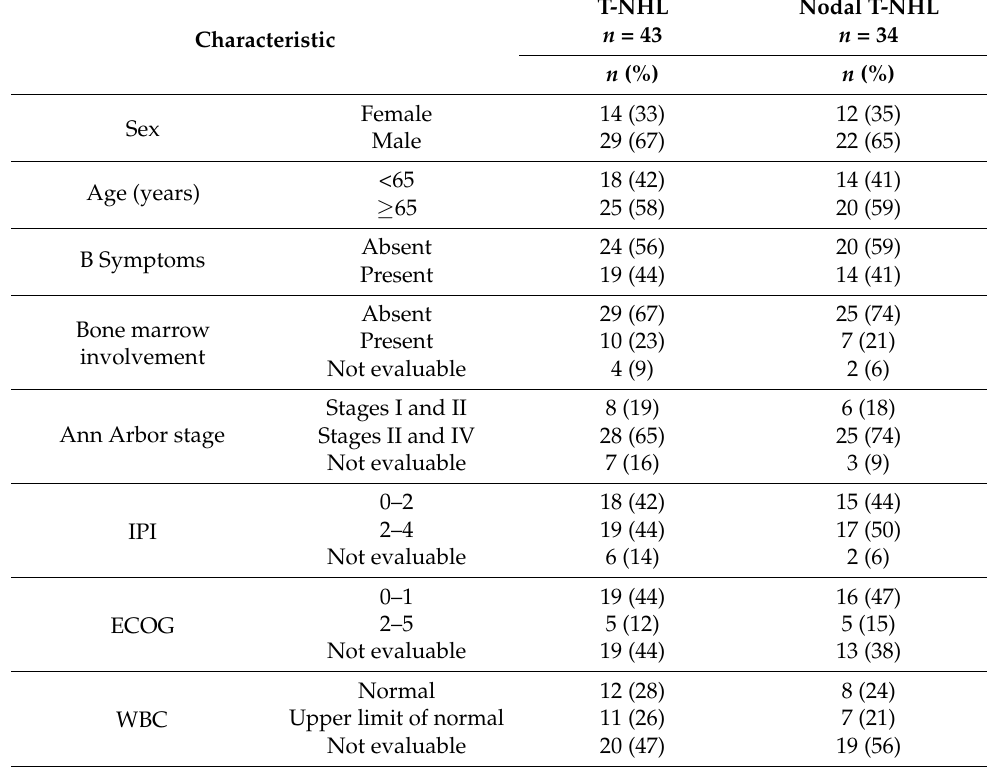
Table 1. Characteristics of